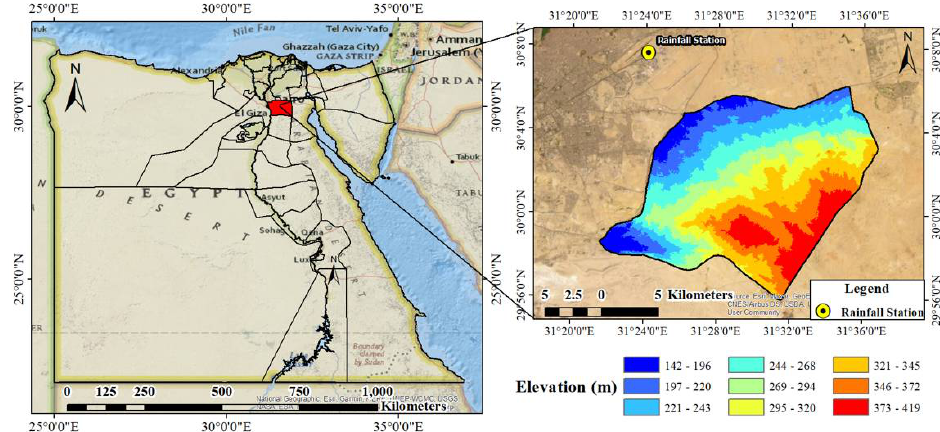
Figure 1. Location and topography of the study area.